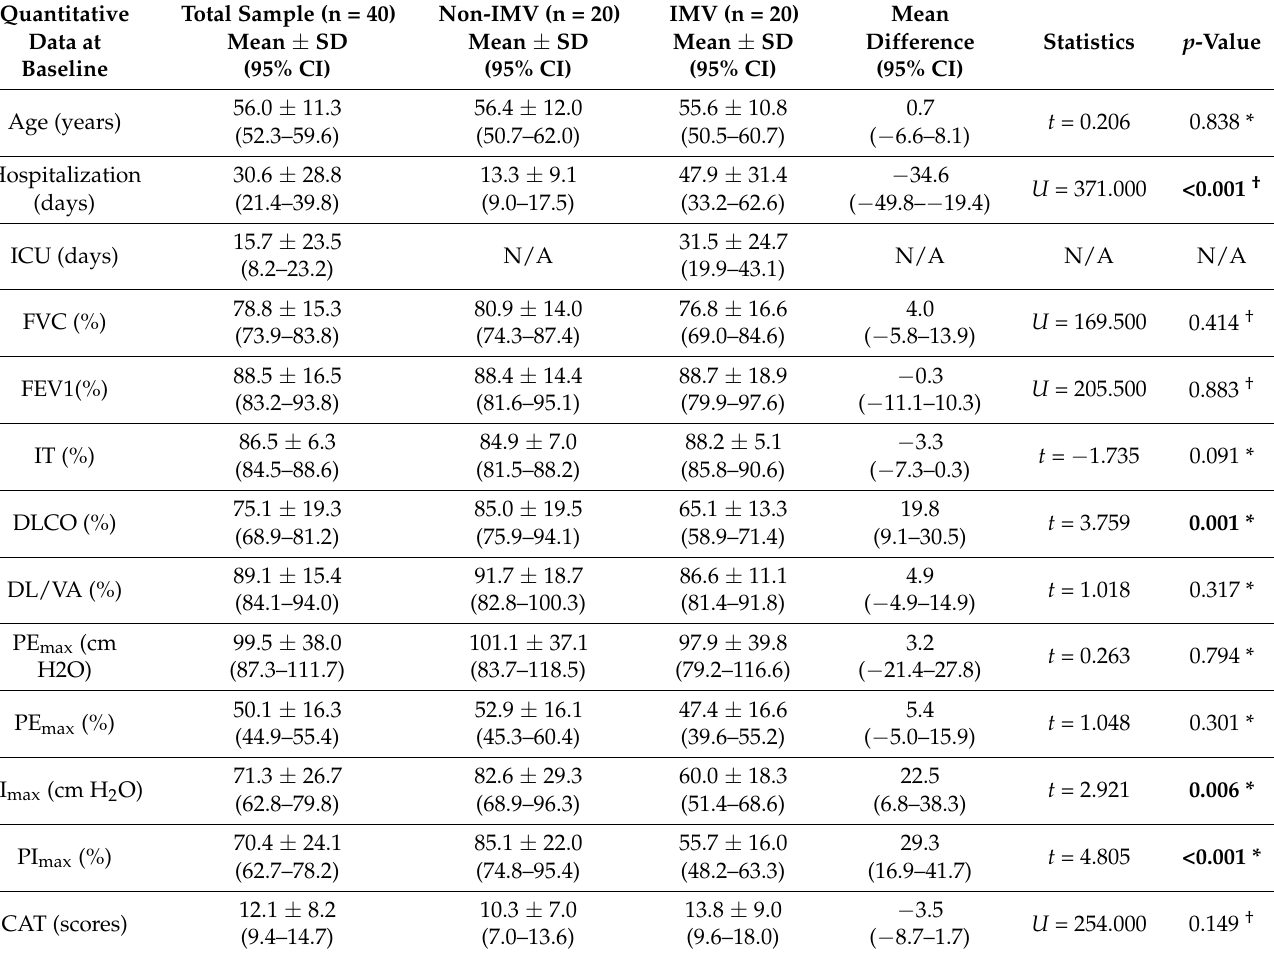
Table 1. Quantitative data for COVID-19 patients with and without IMV at